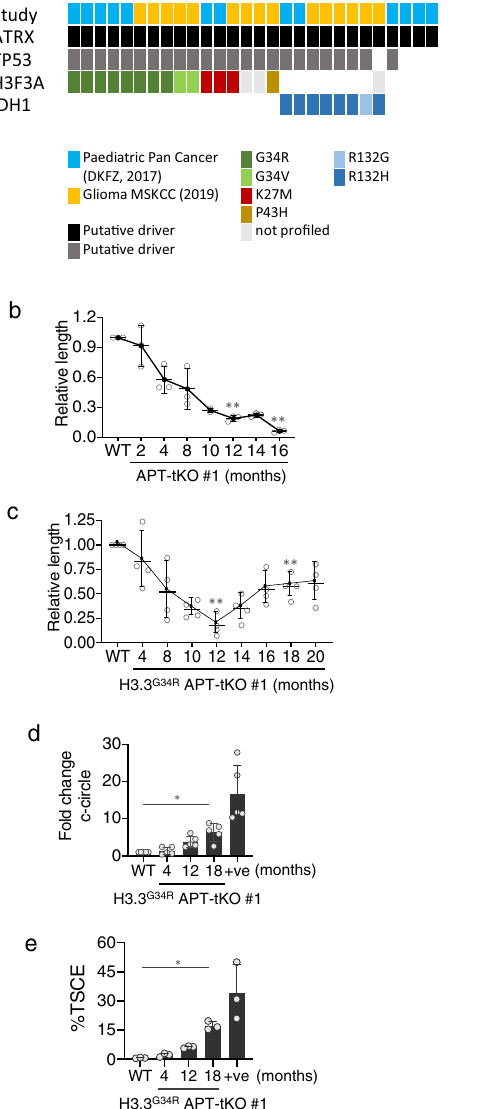
(Fig. 2g, h, Supplementary Fig. S7d), while wild-type (WT) cells